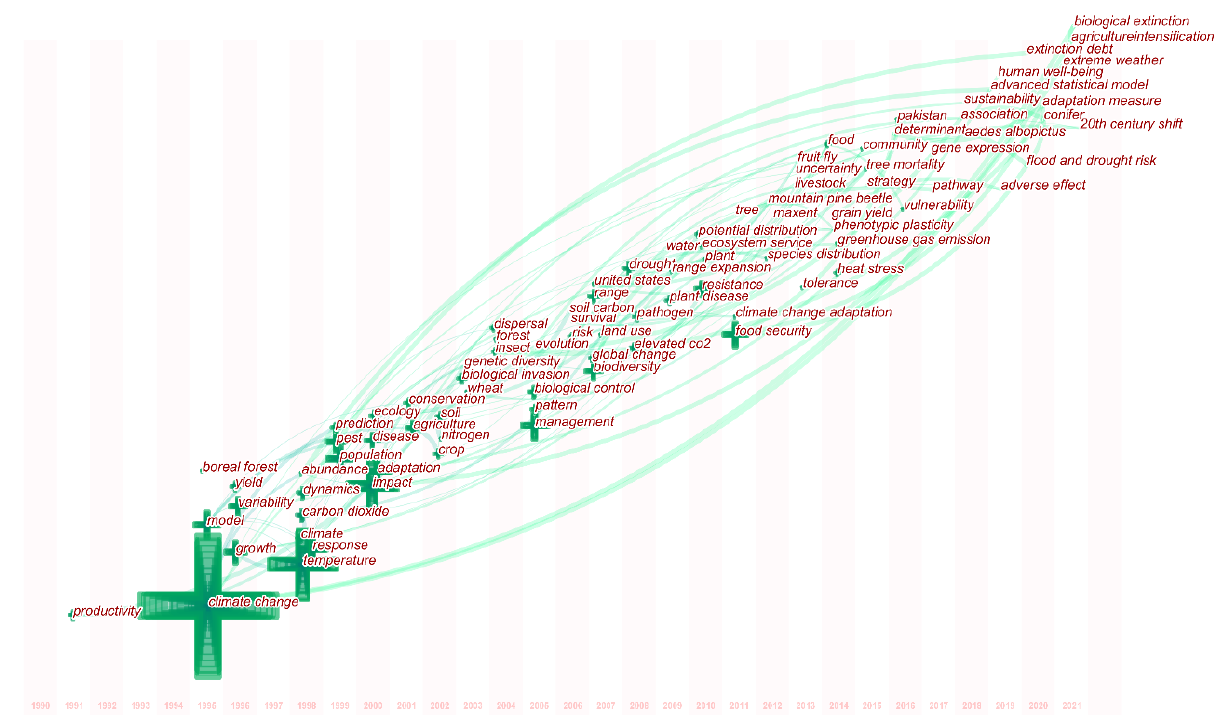
Figure 8. Keyword time zone map of highly cited papers from 1990 –2021.